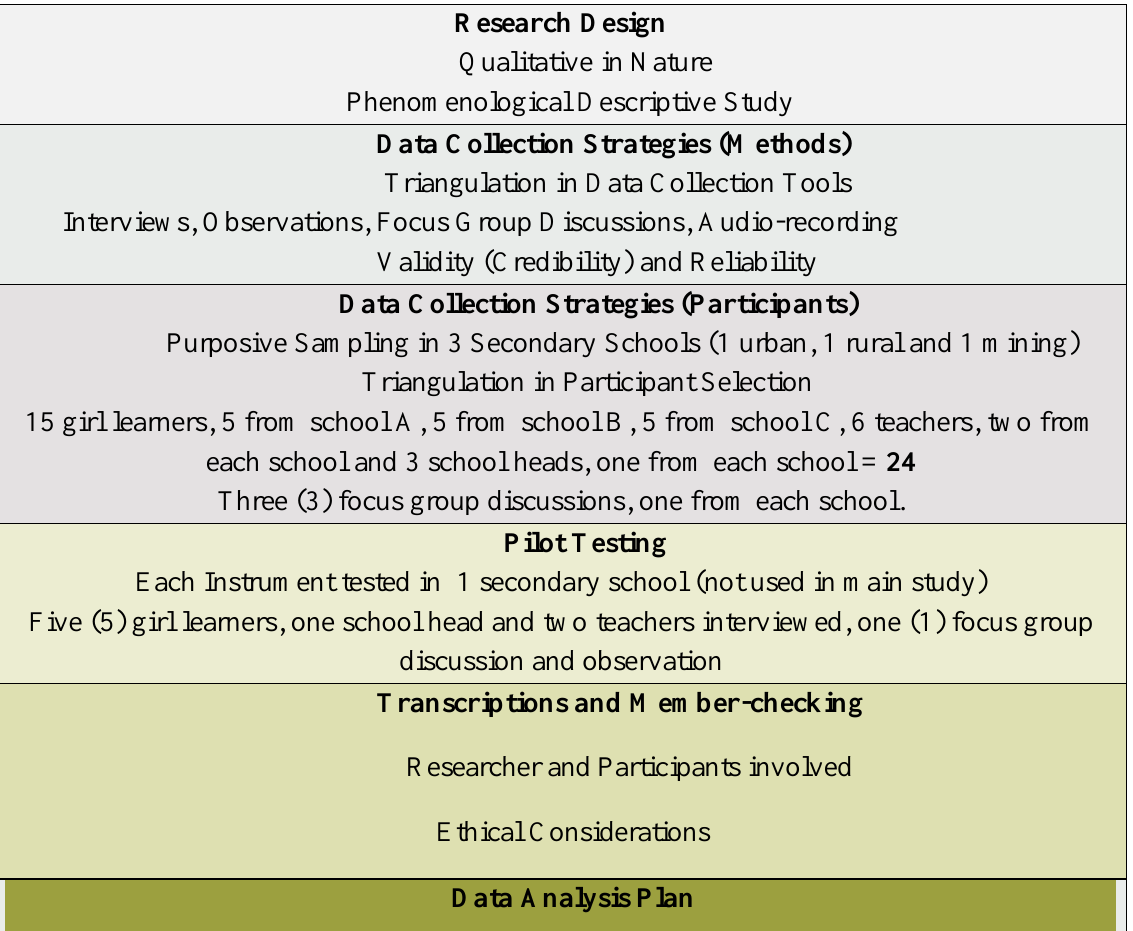
Table 4.1: The research design and